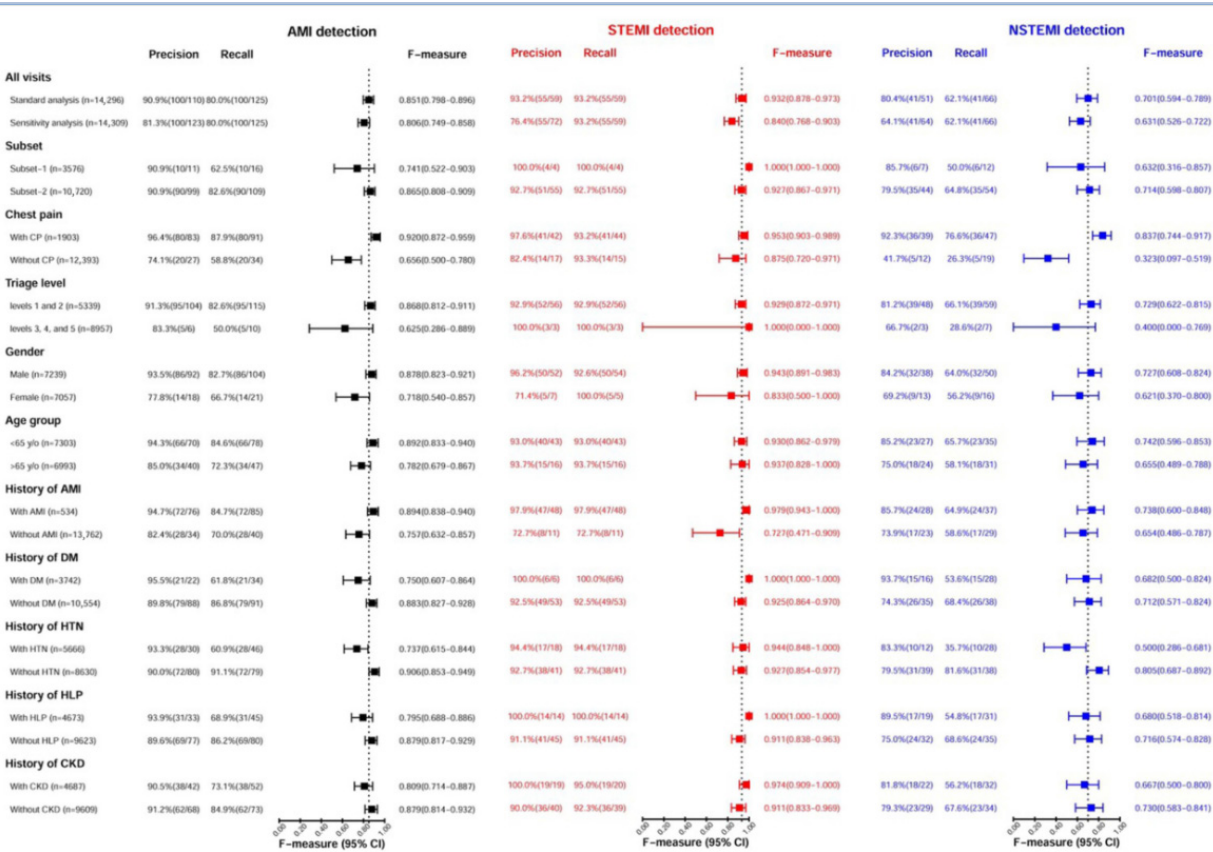
Figure 5. Stratified analyses for the performance of AI-based alarm strategy in AMI, STEMI, and NSTEMI in the prospective cohort. The 95% CI of F-measures was calculated based on 10,000 bootstrapping experiments. For the standard analysis, the F-measure of AMI detection was 0.851 (95% CI: 0.798–0.896), the F-measure of STEMI detection was 0.932 (95% CI: 0.878–0.973), and the F-measure of NSTEMI detection was 0.701 (95% CI: 0.594–0.789).